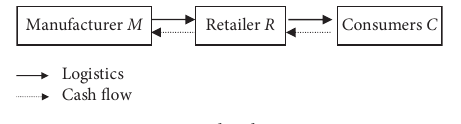
Figure 1: Supply chain Table 1: Notations.